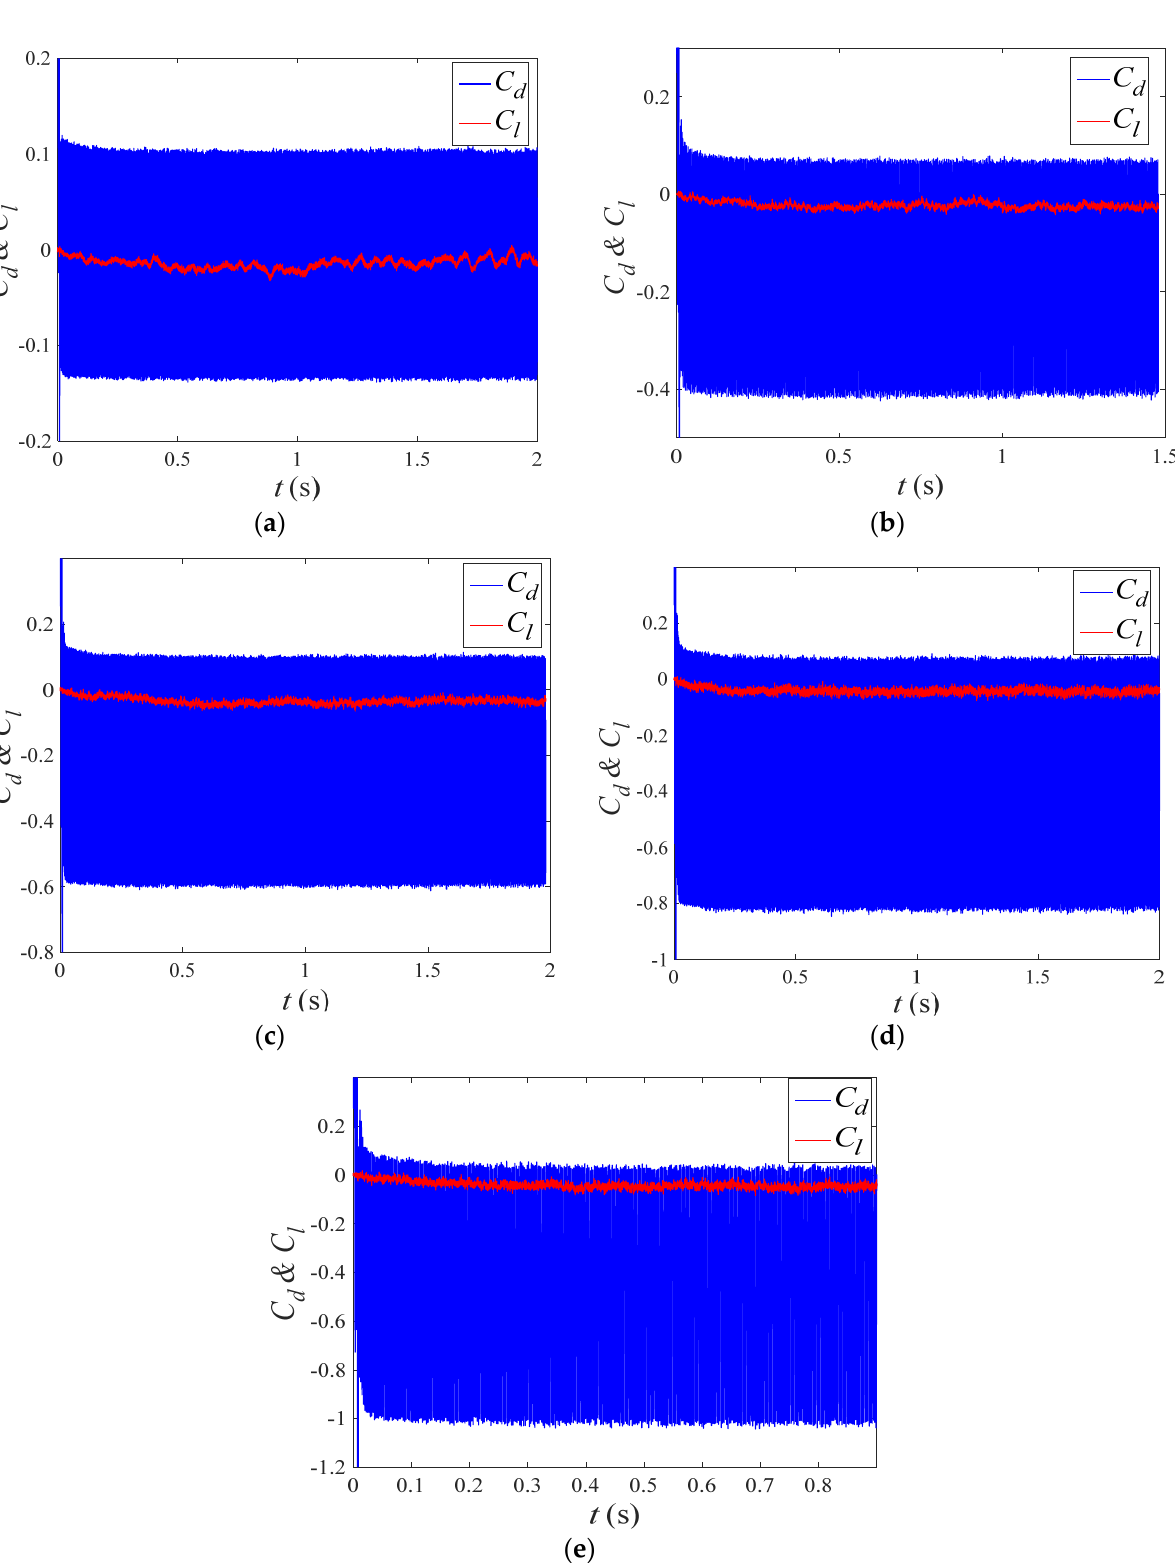
Figure 10. Lift and drag coefficients of TWW cylinder under various wave amplitudes. ( a ) ˆ A / D = 0.01. ( b ) ˆ A / D = 0.02. ( c ) ˆ A / D = 0.03. ( d ) ˆ A / D = 0.04. ( e ) ˆ A / D = 0.05.